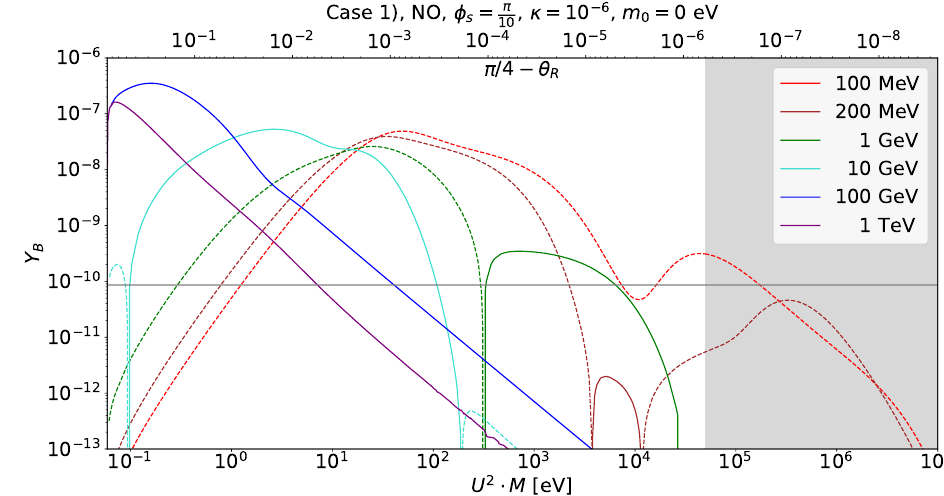
Figure 10 . Case 1) Y B as function of U 2 · M for different values of the Majorana mass M and assuming vanishing initial conditions. The product U 2 · M is introduced, as it is independent of M contrary to U 2 . The splitting κ is fixed to 10 − 6 . Light neutrino masses follow strong NO and φ chosen as π . Both negative (dashed lines) as well as positive (continuous lines) values of the BAU 10 are represented. The grey line indicates the observed value of the BAU, Y shaded area represents the region in which the criterion, given in eq. (3.69), is not fulfilled.